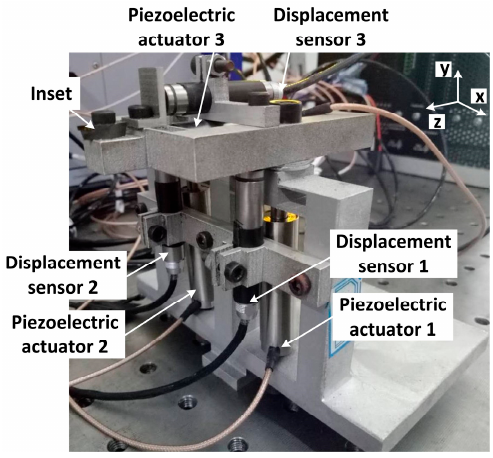
Figure 2. Apparatus of the non-resonant three-dimensional elliptical vibration cutting (3D-EVC) in cutting experiments.